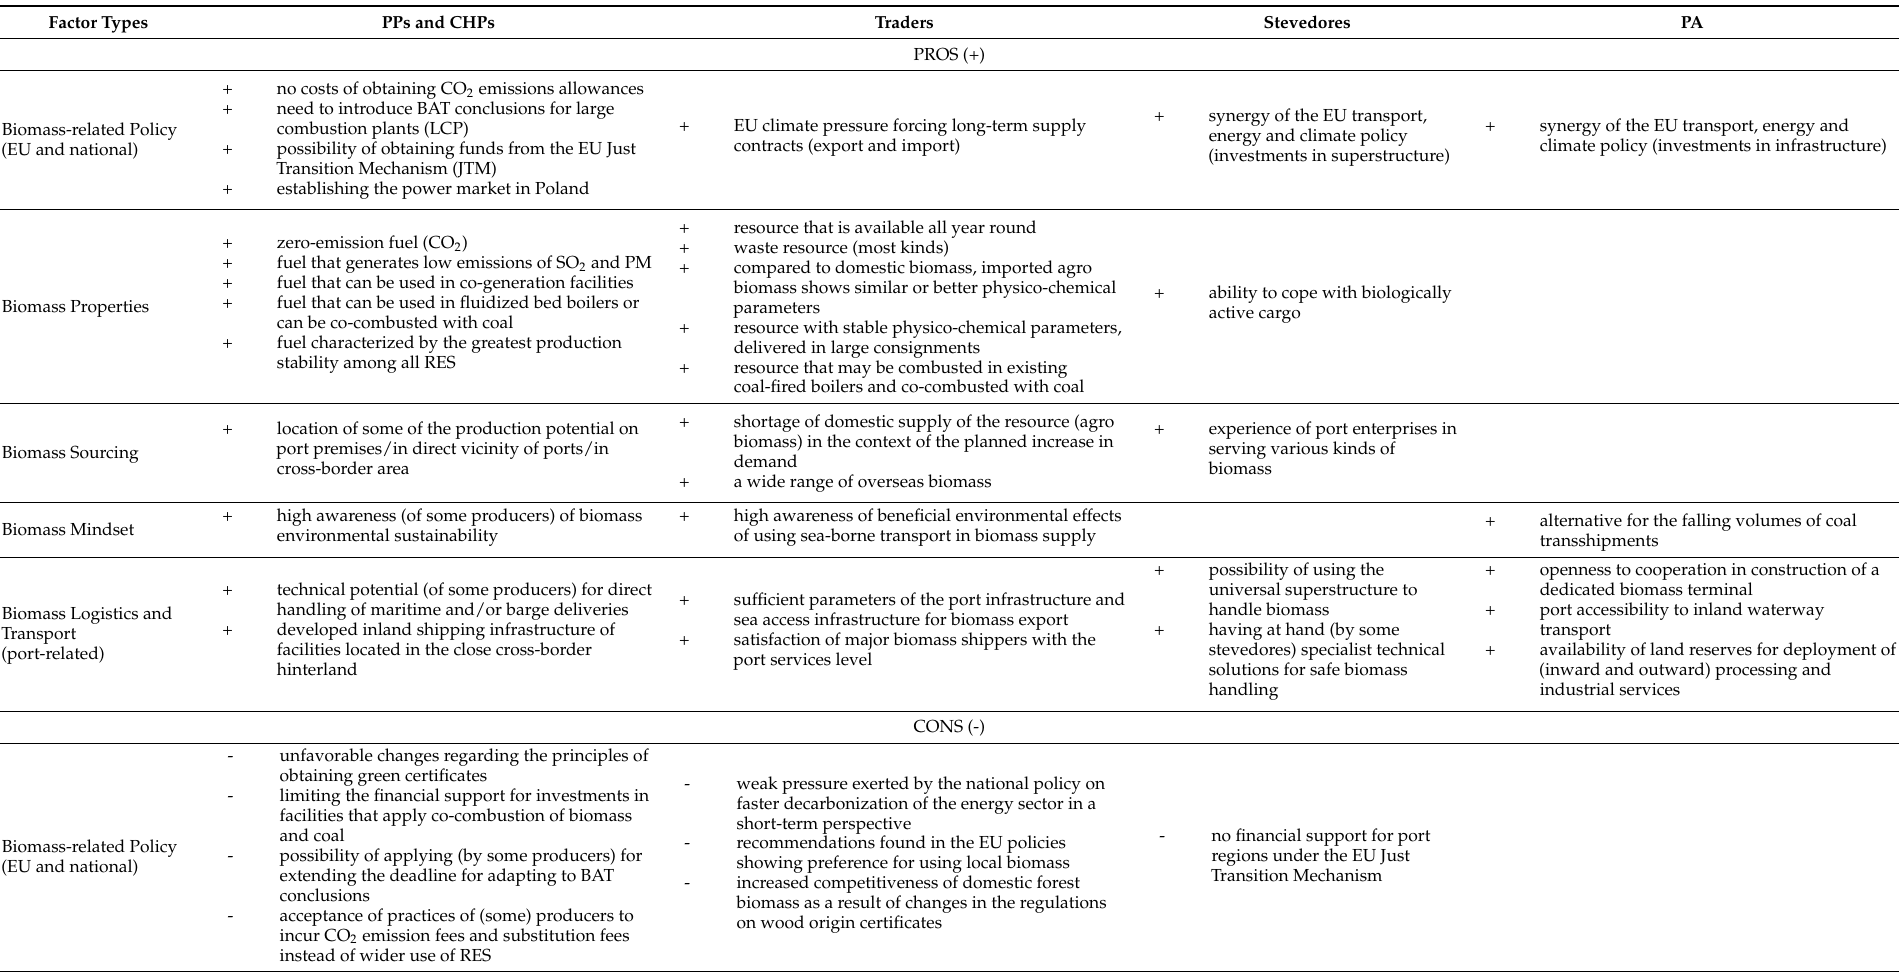
Table 4. The Pros & Cons factors that determine the decision-making about engaging in biomass sea-based supply chains via the secondary port in Szczecin (stakeholders’ perspectives). Factor